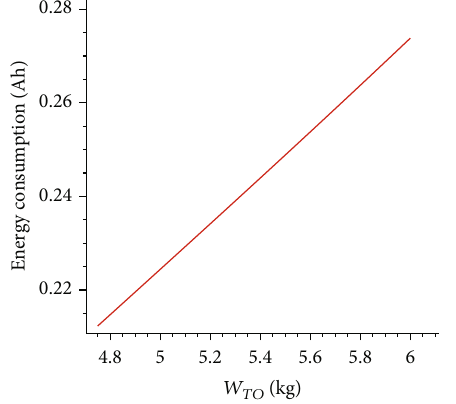
TO under 5 m/s crosswind.